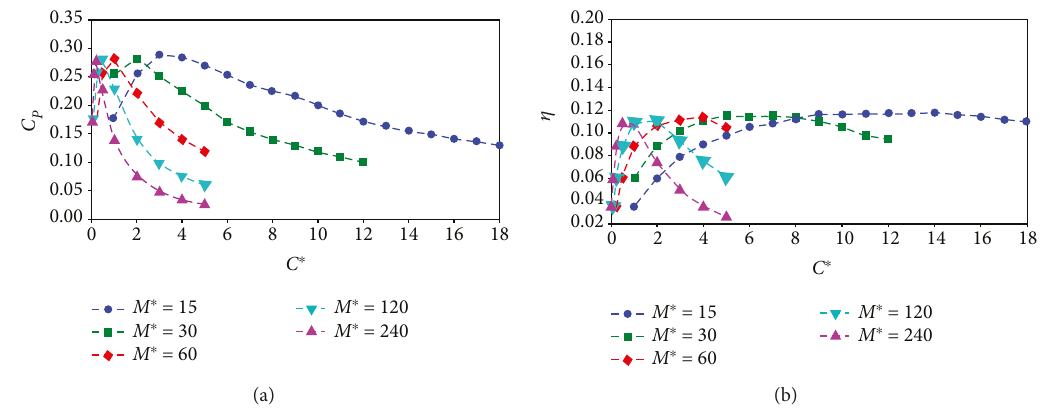
Figure 14: The mean power coe ffi cient and power e ffi ciency against damping coe ffi cient C ∗ with di ff erent mass ratio M ∗ ; (a) mean power coe ffi cient; (b) power e ffi